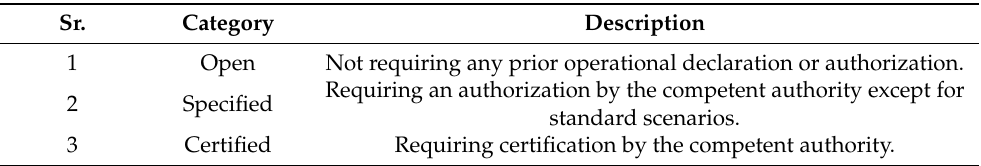
Table 3. Three categories established by European Union Aviation Safety Agency (EASA) for operat- ing